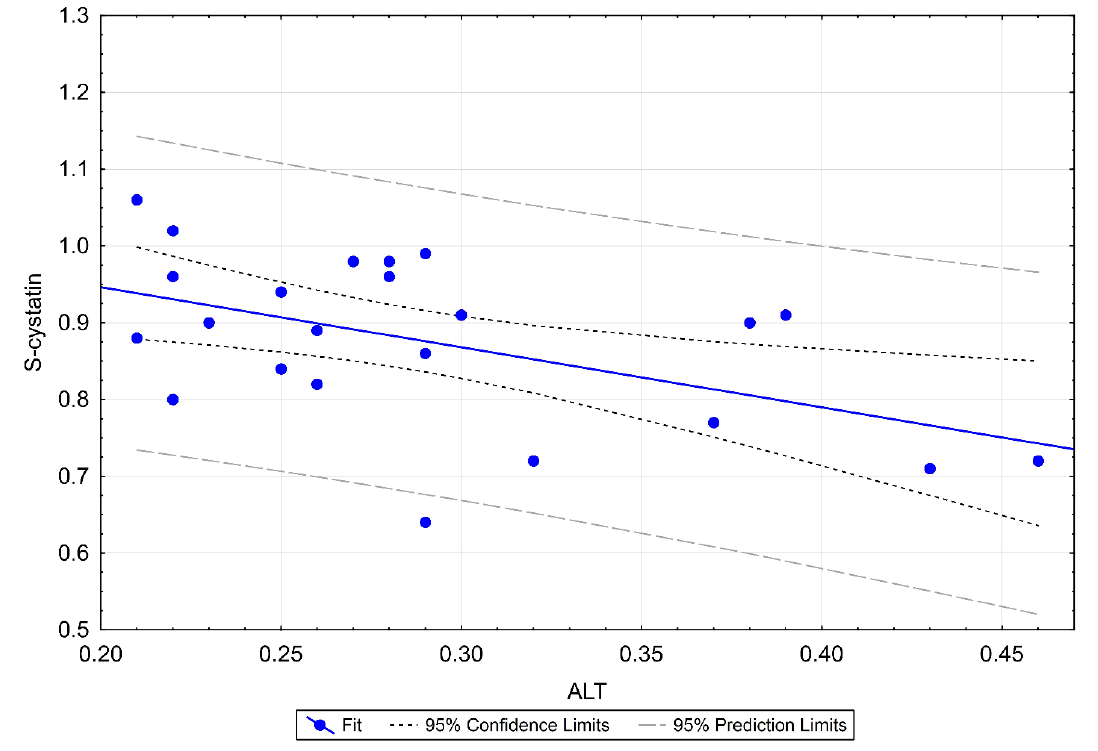
Figure 6. Linear regression of ALT and S-cystatin C in MIS-C. Moderately strong, negative correlation confirmed. ALT: alanine transaminase; MIS-C: multisystem inflammatory syndrome in chil- dren.